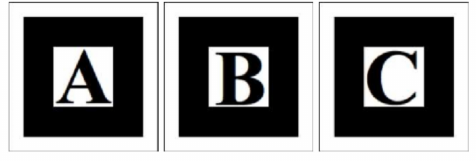
Figure 21. PATTERN markers.